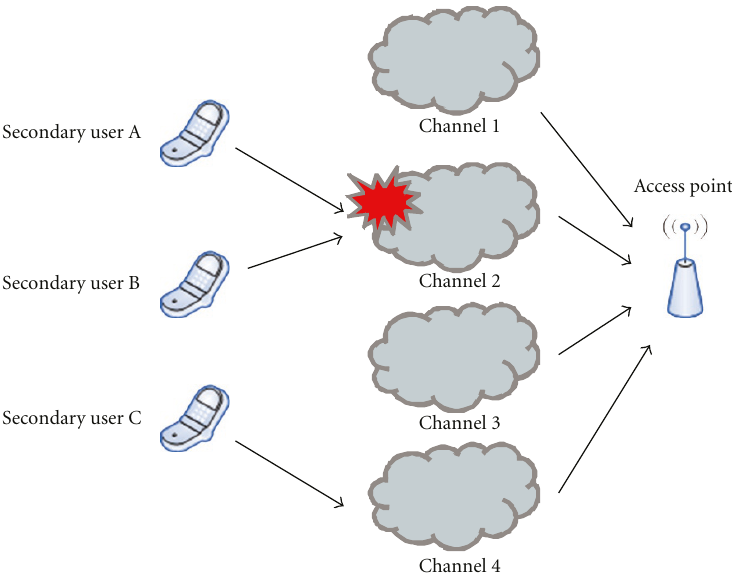
Figure 1: Illustration of competition and conflict in multiuser and multichannel cognitive radio